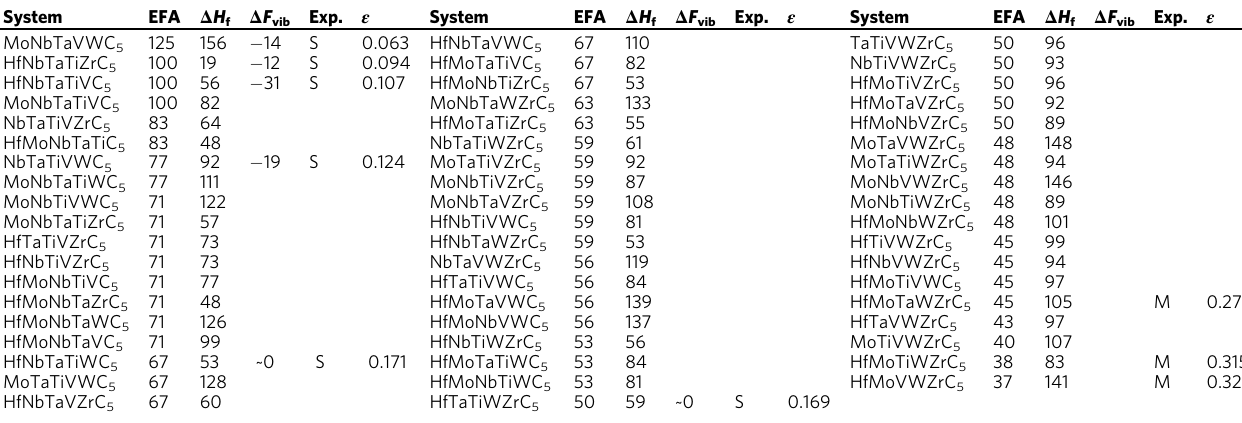
Table 1 Results for the calculated entropy-forming-ability (EFA) descriptor, energetic distance from six-dimensional convex hull ( Δ H f ) and vibrational free energy at 2000 K ( Δ F vib ) for the fi ve-metal carbide systems, arranged in descending order of EFA